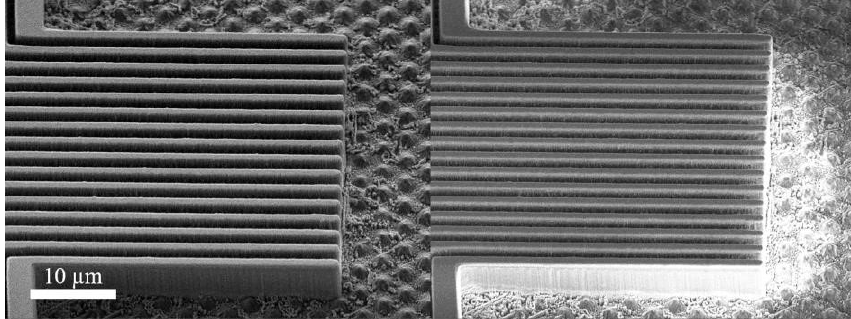
Figure 3. SEM images of 1 µm InGaN/GaN fin LED arrays after hybrid etching